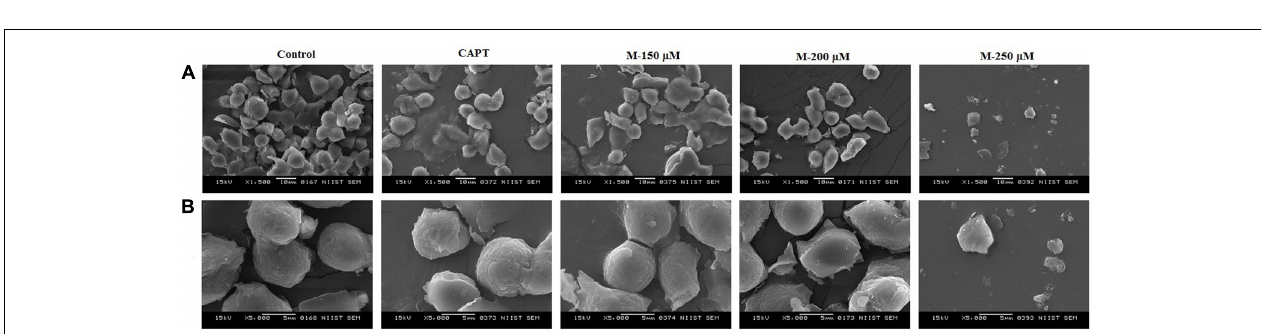
FIGURE 1 | Morin induces cytotoxicity in SW480 colon cancer cells. (A) SW480 cells were treated with various concentrations of morin (50–500 µ M) for 24 and 48 h. Cell viability was measured sing MTT assay. Results are shown as percentage reduction in cell viability of treated cells compared to untreated control cells. Values shown are the means ± SD obtained from three independent experiments. (B) Representative images when taken using phase contrast microscope. CAPT: camptothecin (50 µ M), M (100, 200, and 300 µ M): Morin (100, 200, and 300 µ M). Significance levels between different groups were determined by using one way ANOVA, followed by Duncan’s multiple range test ∗ p ≤ 0.05 versus control, 24 h; # p ≤ 0.05 versus control 48 h.